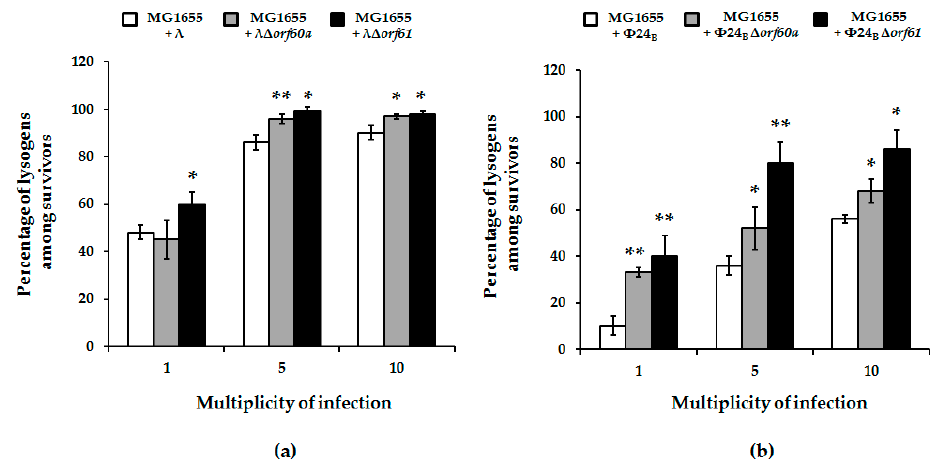
Figure 6. Fraction of lysogens among survivors of E. coli MG1655 bacteria after infection with wild-type bacteriophages: λ (panel ( a ); white columns) and Φ 24 B (panel ( b ); white columns) or their deletion mutants: λ ∆ orf60a (panel ( a ); grey columns), λ ∆ orf61 (panel ( a ); black columns), Φ 24 B ∆ orf60a (panel ( b ); grey columns), and Φ 24 B ∆ orf61 (panel ( b ); black columns). Results are presented as mean values ± S.D. from three independent experiments. A t -test was performed for results from each m.o.i. Statistically significant differences between wild-type phage and its deletion mutants are marked by asterisks, p < 0.05 (*) or p < 0.01 (**).